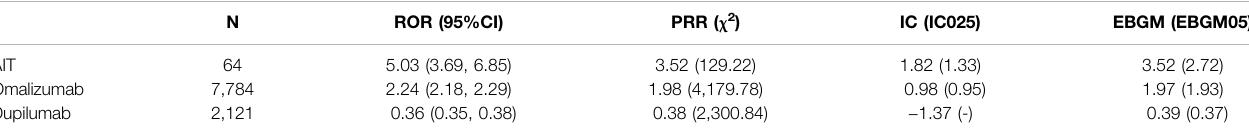
TABLE 3 | Comparison of anaphylaxis signals associated with AIT, omalizumab, and